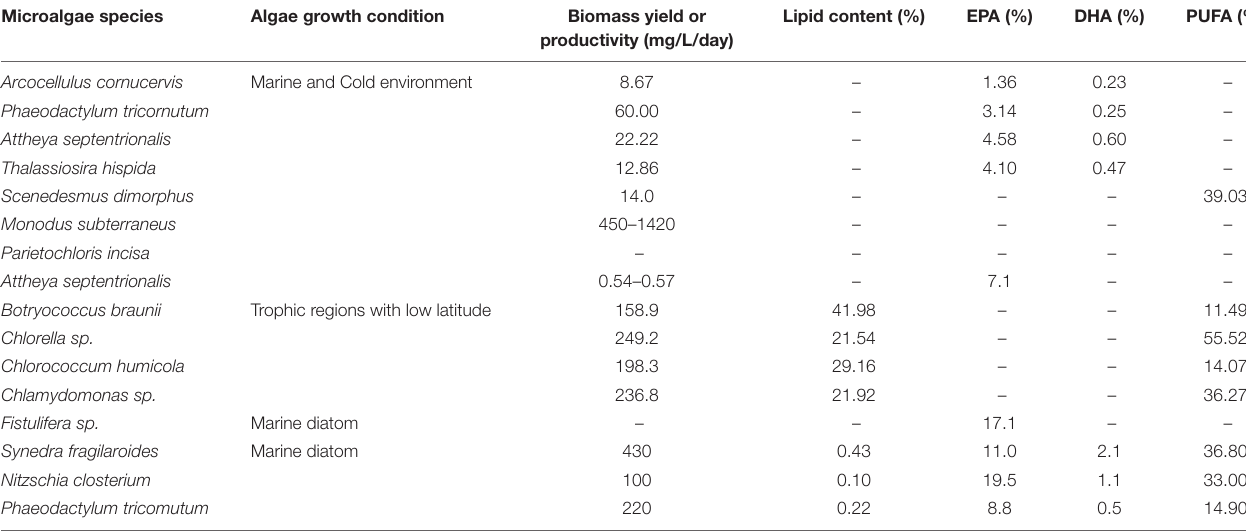
TABLE 2 | Screening of algal strains with the potential for PUFAs production (27,